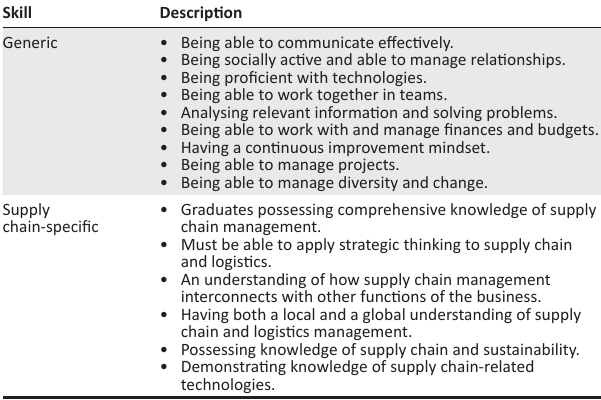
TABLE 2: The skills expectations as set out in the supply chain management graduate requirement